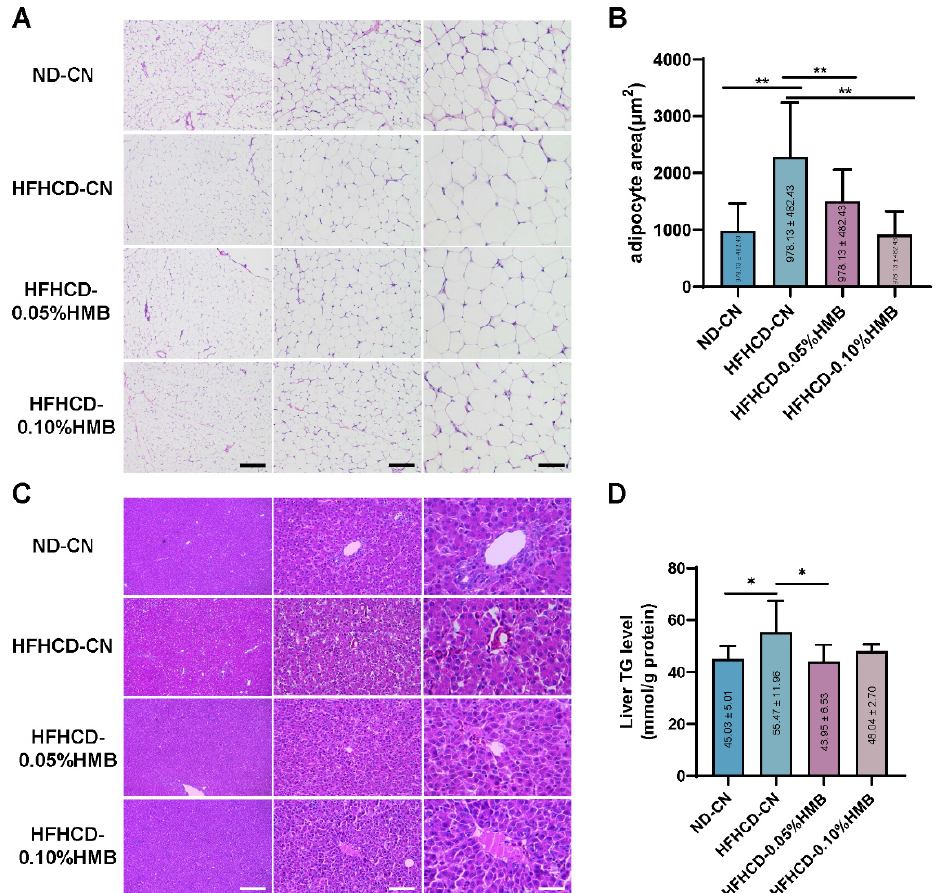
Figure 3. Effects of HMB on adipose and hepatic lipid content in HFHCD − challenged layers. ( A ) Representative images of abdominal adipose tissue with H&E staining, viewed under a microscope (40 × , 100 × , and 400 × ) ( B ) ImageJ analysis of fat cell area size according to panel A ( n ≥ 90). ( C ) H&E staining of layer liver section, viewed under a microscope (40 × , 100 × , and 400 × ). ( D ) Liver triglycerides (TG) levels ( n = 8). All the results are shown as the means ± SDs; * p < 0.05, ** p < 0.01.